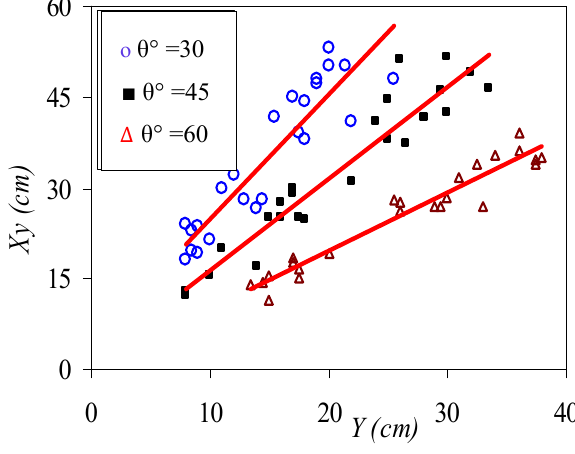
Figure 6. Maximum jet centerline level versus its horizontal distance with respect to initial jet